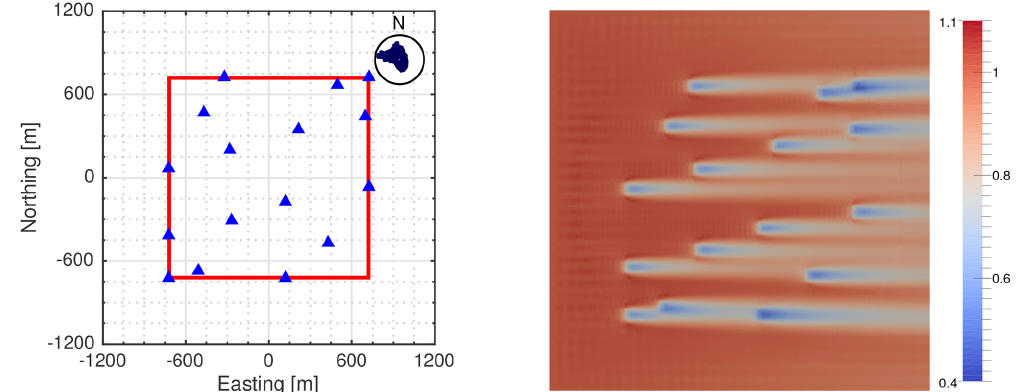
Figure 9. Optimal layout (left) and flow field (right) for the NWTC M2 8ms − 1 test case with the wind rose binned into 36 inflow directions. The wind rose is shown in the upper right corner of the left panel, and the site boundary is shown by a solid red line. Turbine locations are denoted by blue triangles. The flow field in the right panel is normalized by the incoming hub-height velocity of 8ms − 1 and shows results for an inflow wind from the